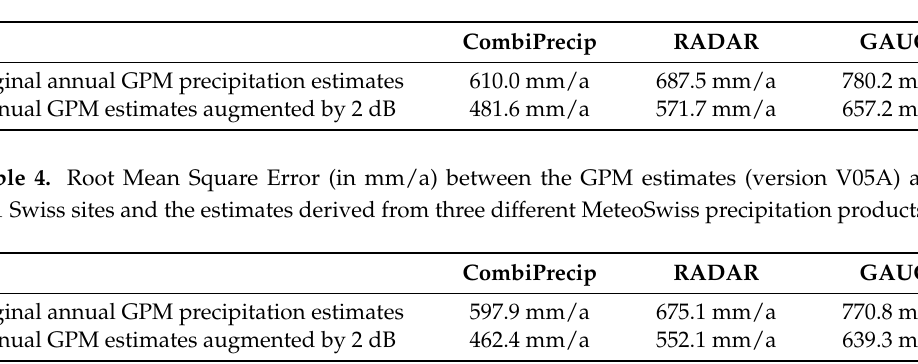
Table 3. Root Mean Square Error (in mm/a) between the GPM estimates (version V04A) above 221 Swiss sites and the estimates derived from three different MeteoSwiss precipitation products.